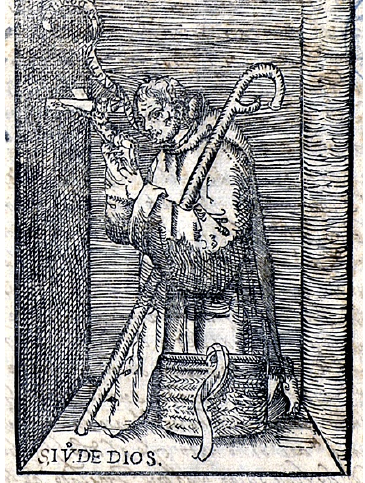
Figure 7. Anonymous. Rostro de Dios . Book cover of Francisco de Castro: Historia de la vida y sanctas obras de Iuan de Dios … En Granada en casa de Rene Rabut. Año de 1588.